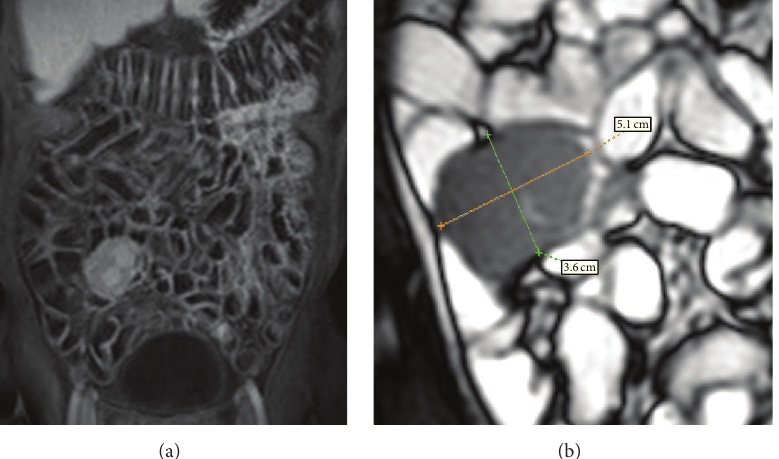
Figure 5: Round lesion, with regular contours, in patients with frequent occlusive syndromes. It shows moderate enhancement in post- gadolinium sequences (a). Definitive histology: